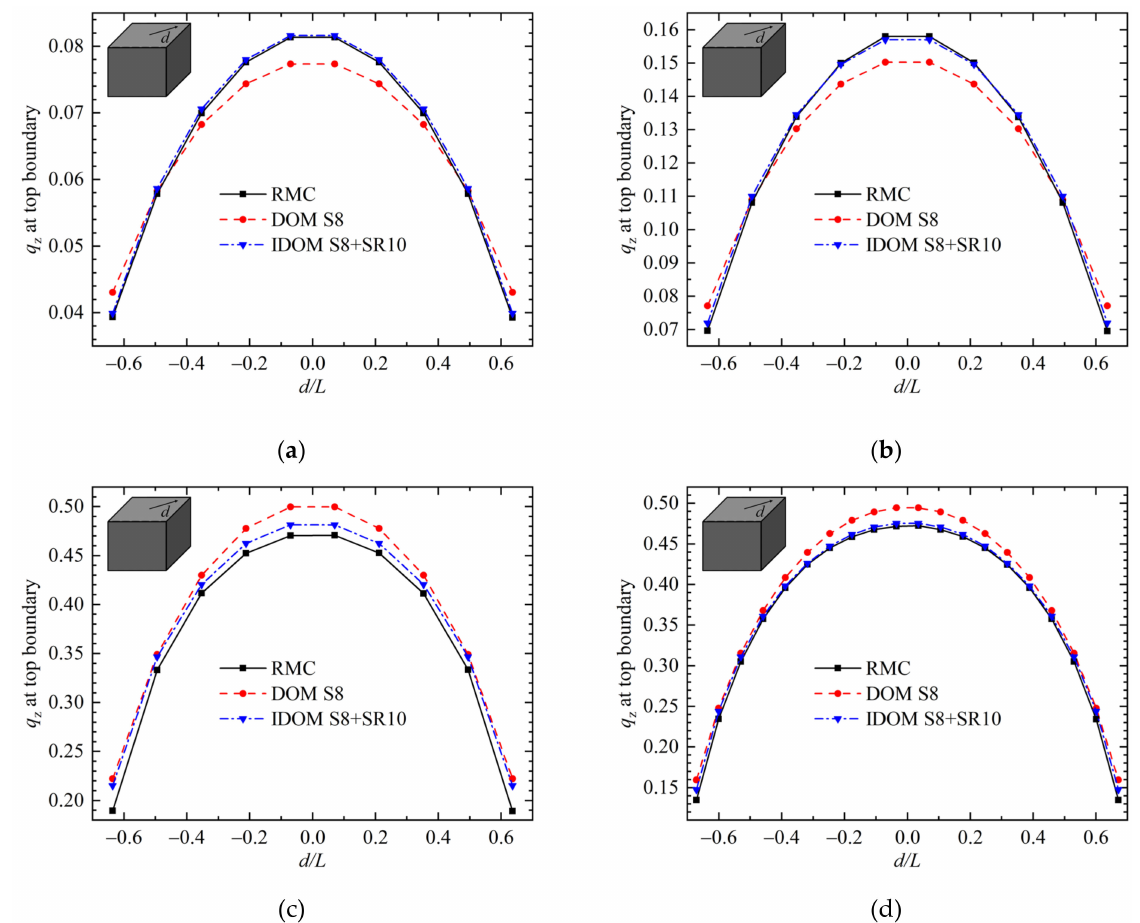
Figure 7. Heat flux of Case 3 with different optical thicknesses ( a ) β L = 1.0 and NX = 10; ( b ) β L = 2.0 and NX = 10; ( c ) β L = 10.0 and NX = 10; ( d ) β L = 10.0 and NX =